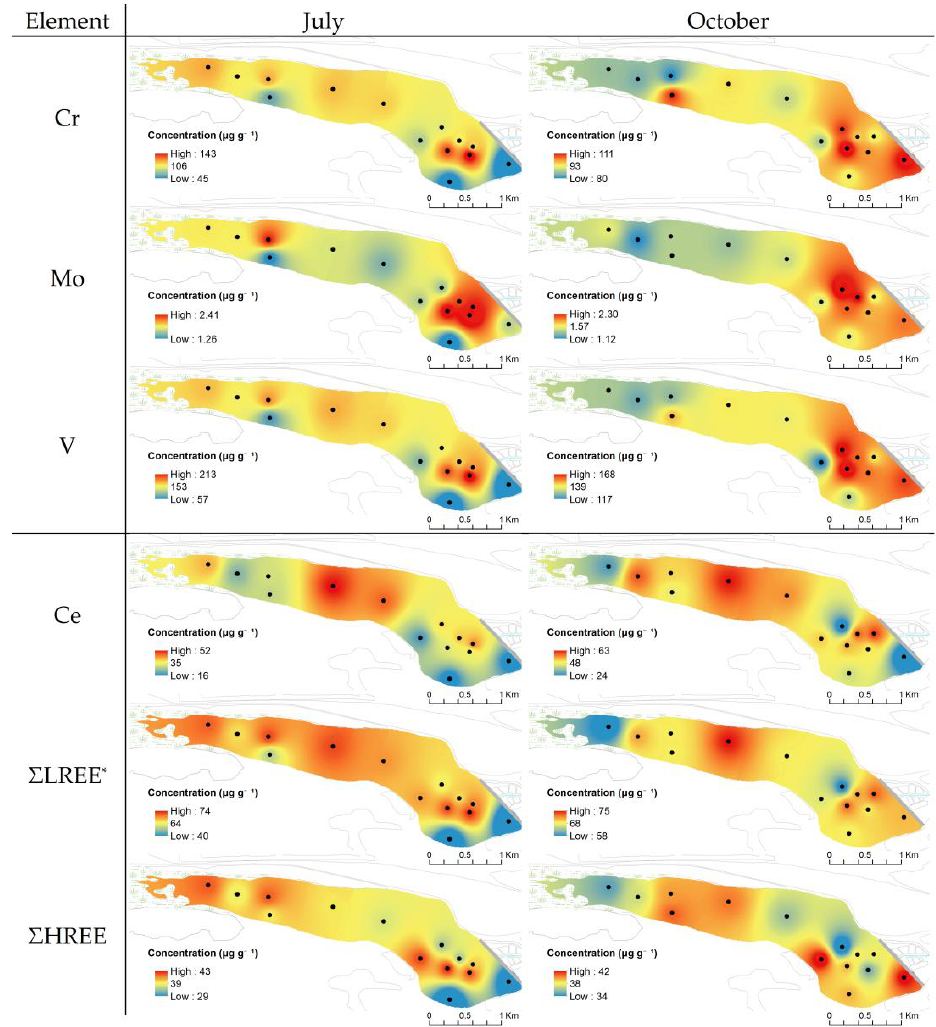
Figure 3. Spatial distribution of selected TEs (As, Ba, Cd, Co, Mn, Pb, Tl, and Zn), REs (Cr, Mo, and V) and Ce, ΣLREE*, and ΣHREE in the sediment of Podu Iloaiei Dam Lake for the July and October sampling sessions.